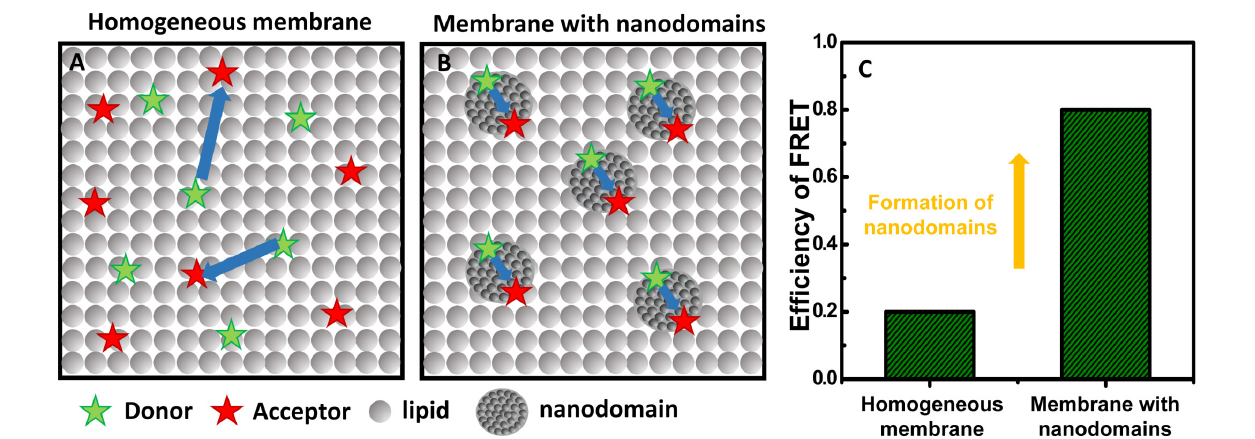
FIGURE 4 | Basic principles of MC-FRET for detection of nanodomains. (A) At a sufficiently high acceptor concentration in the bilayer, FRET between donors (green stars) and acceptors (red stars) occurs. (B) If donors and acceptors with high affinity for nanodomains are used, the presence of nanodomains leads to accumulation of donors and acceptors in the nanodomains, and consequently to a more efficient FRET. (C) The efficiency of FRET on a homogeneous vs a heterogeneous membrane with nanodomains.